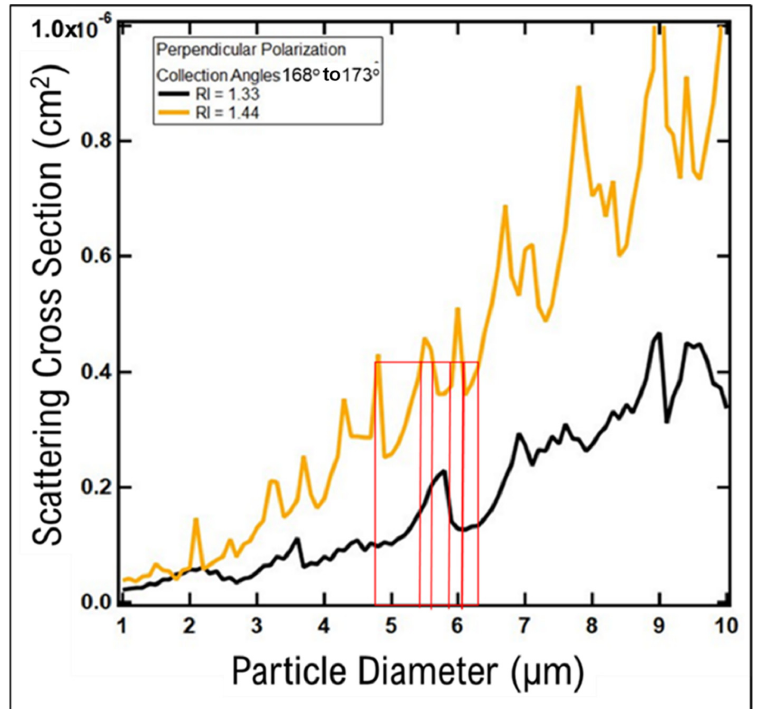
Figure 3. The relationship between the light scattered by an illuminated single particle, as a function of size, is non-monotonic and highly sensitive to the refractive index of the particles, as highlighted by the vertical red lines.